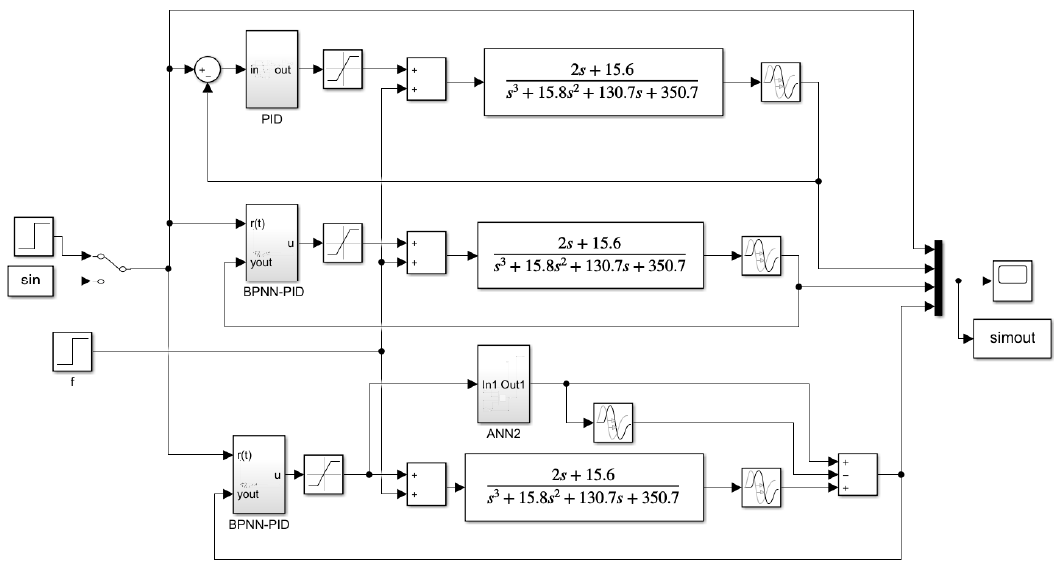
Figure 11. MATLAB Simulink simulation block diagram.